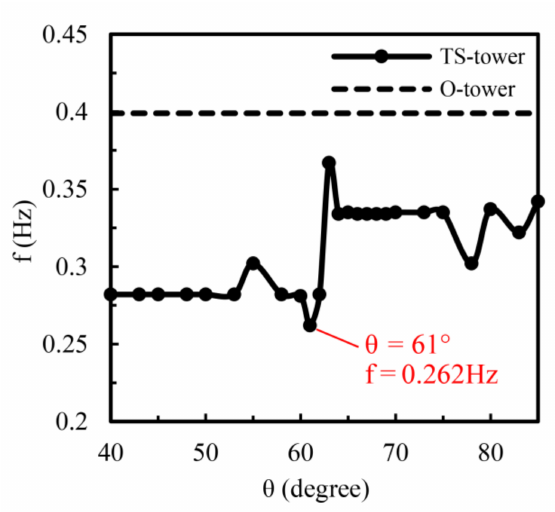
Figure 8. Influence of the θ parameter on the VIV frequency.